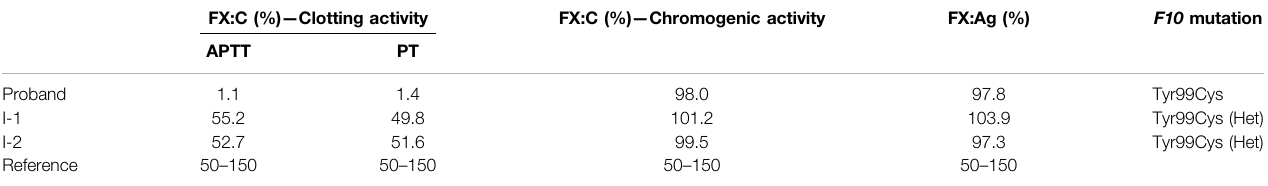
TABLE 2 | Clotting function and genetic pro fi le of the pedigree.